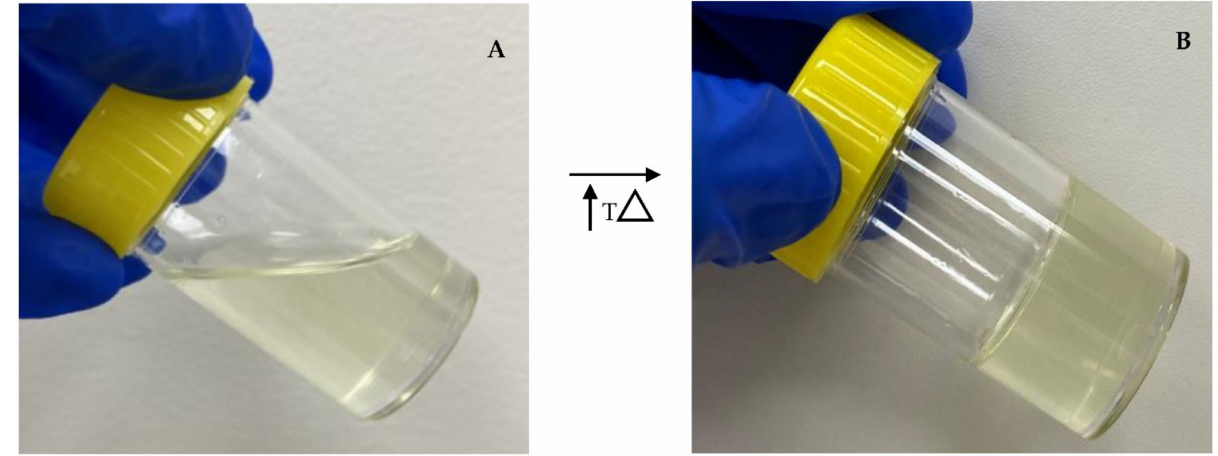
Figure 4. Representative photograph of F3. ( A ) Sol form at storage temperature 2–8 ◦ C. ( B ) Gel form at nasal temperature 32 − 34 ◦ C.